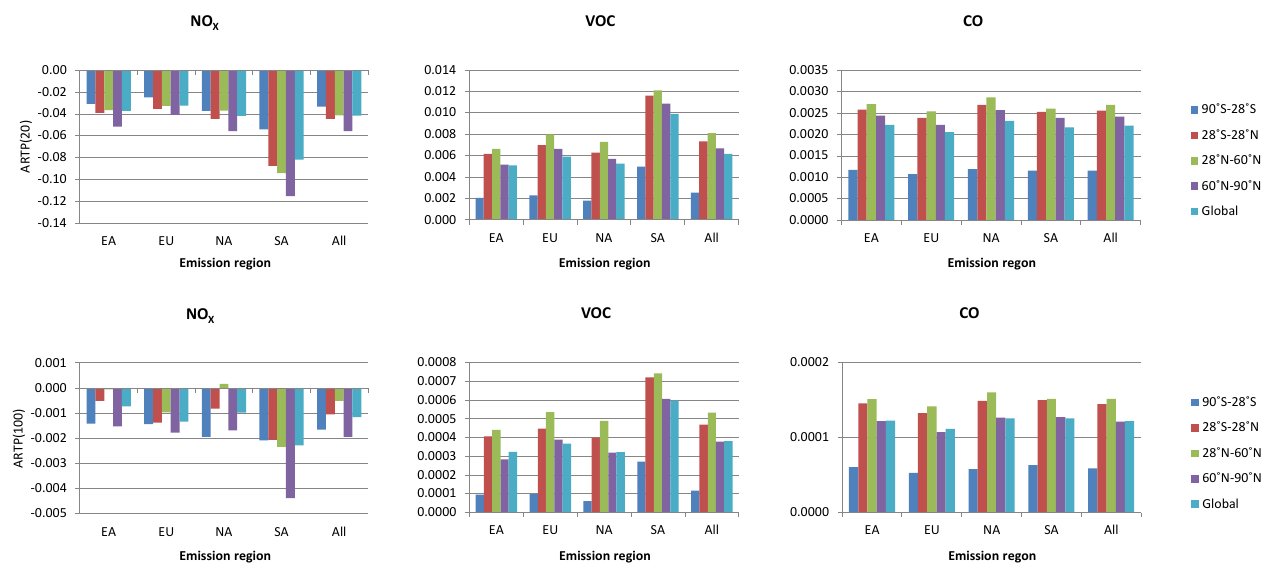
Fig. 8. ARTP(20) and ARTP(100) in mK/Tg for emissions of NO x , VOC and CO from the four HTAP continents. The coloured columns represent the temperature responses in 4 different latitude bands (90 ◦ S–28 ◦ S, 28 ◦ S–28 ◦ N, 28 ◦ N–60 ◦ N, 60 ◦ N–90 ◦ N) and